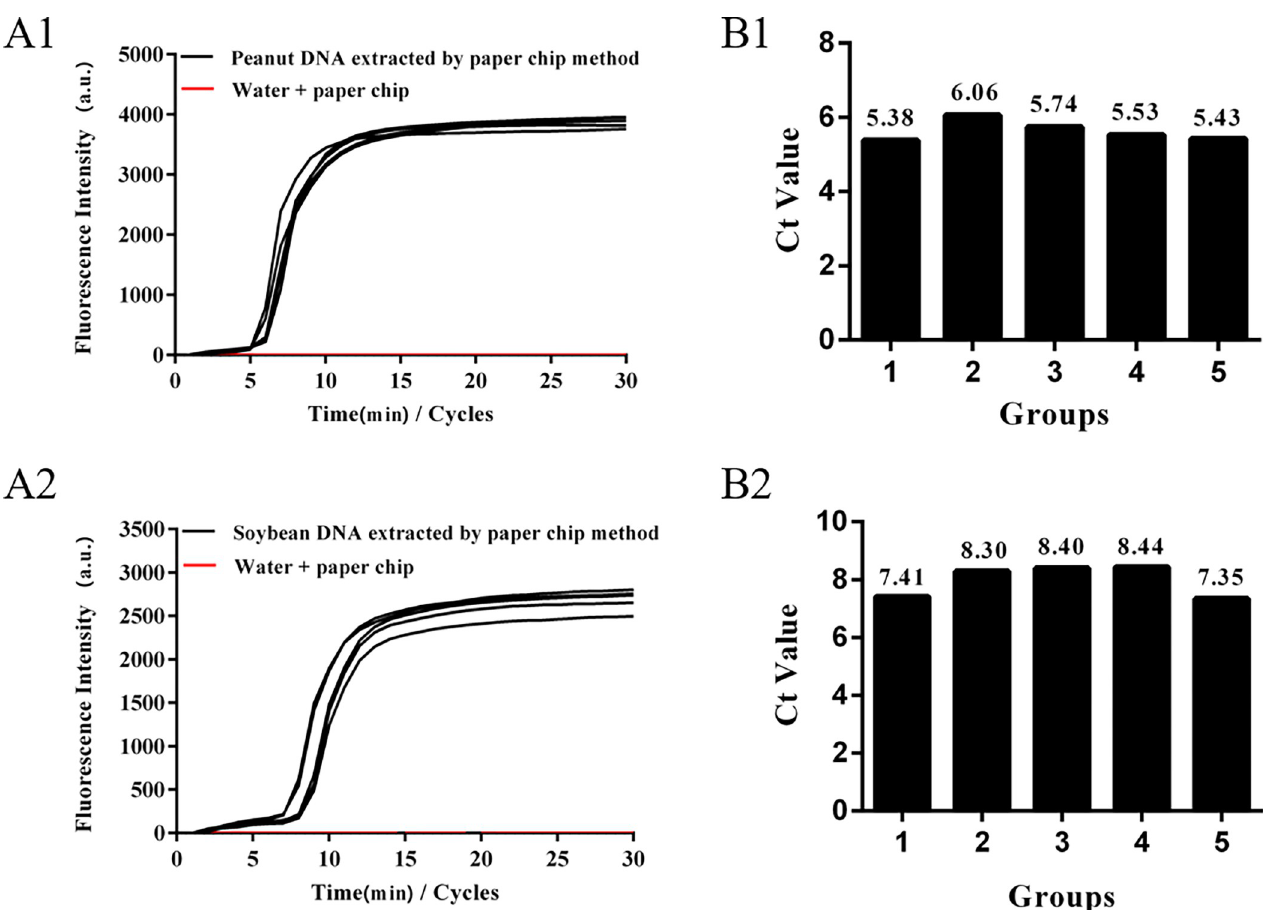
Fig 7. Repeatability of LAMP detection with paper-based microfluidics extraction. Notes: A1 & A2, the amplification results of peanut and soybean with 5 repeats; B1 & B2, Ct value of peanut and soybean with 5 repeats.